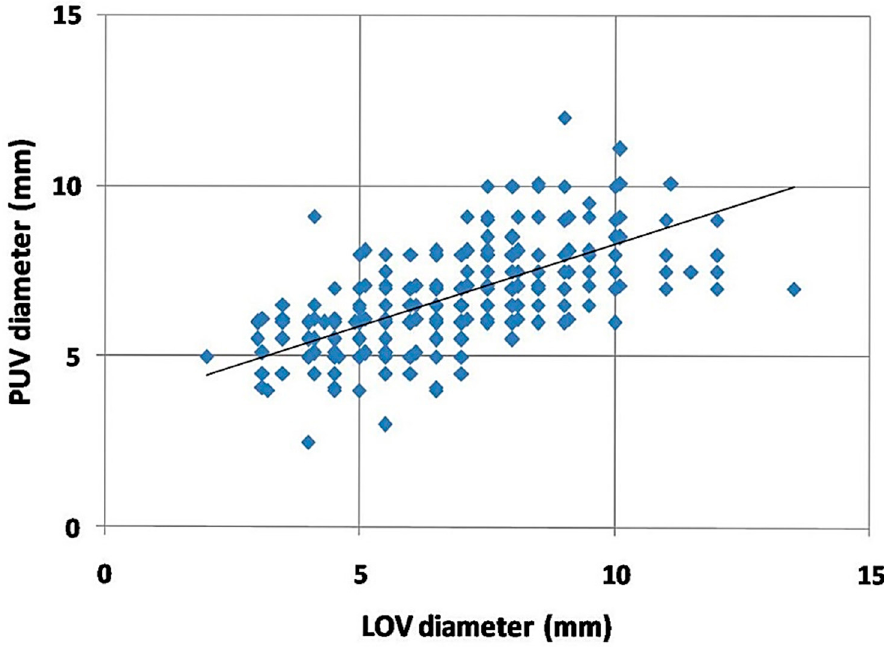
Figure 3. Correlation of the dilatation of the para-uterine venous plexuses (PUV) compared to the dilatation of the left ovarian vein (LOV) trunk.